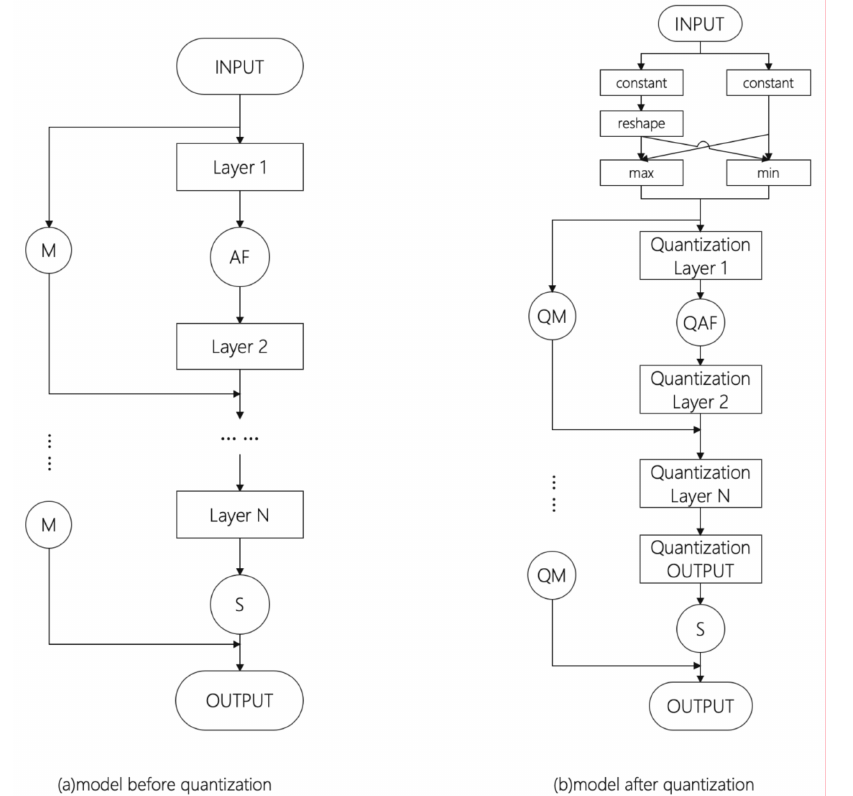
Figure 5. Compare models ( a ) before and ( b ) after quantization.